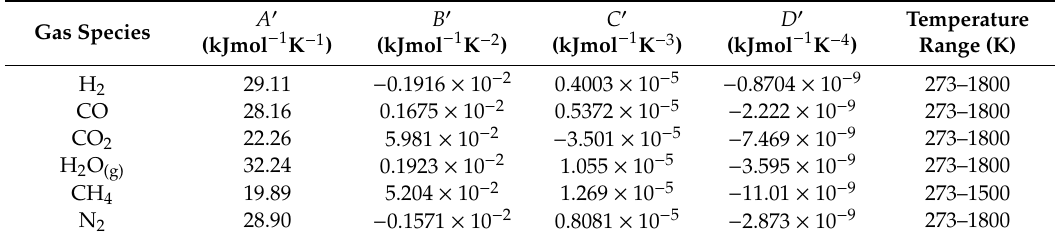
Table 2. The coefficients of specific heat 𝑪𝒑 (kJ/mol) in Equation (17).